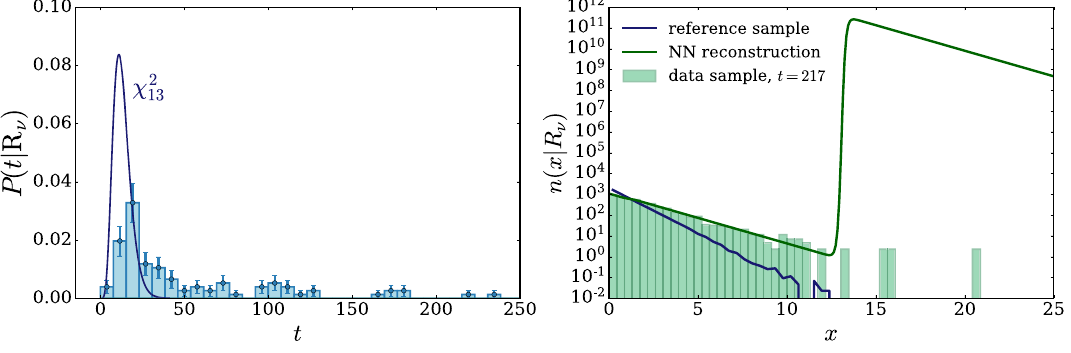
Fig. 7 Left panel: the empirical distribution of t computed with 100 toy experiments for (ν ∗ n ,ν ∗ s ) = ( 0 , 0 . 6 ) . Right panel: neural network reconstruction of the x variable distribution (using Eqs. (4) and (26)) of a single toy experiment for which the test statistic output is an outlier ( t (cid:5)